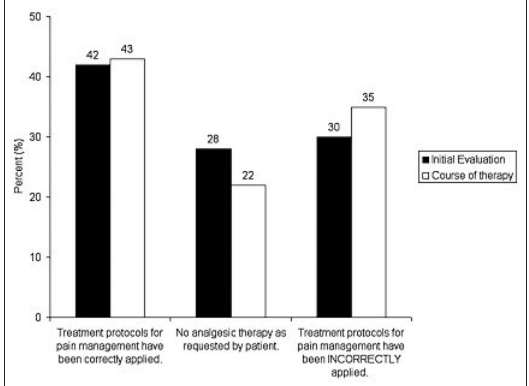
Figure 2 Adherence to pain management protocols at the time of initial evaluation and during course of therapy.